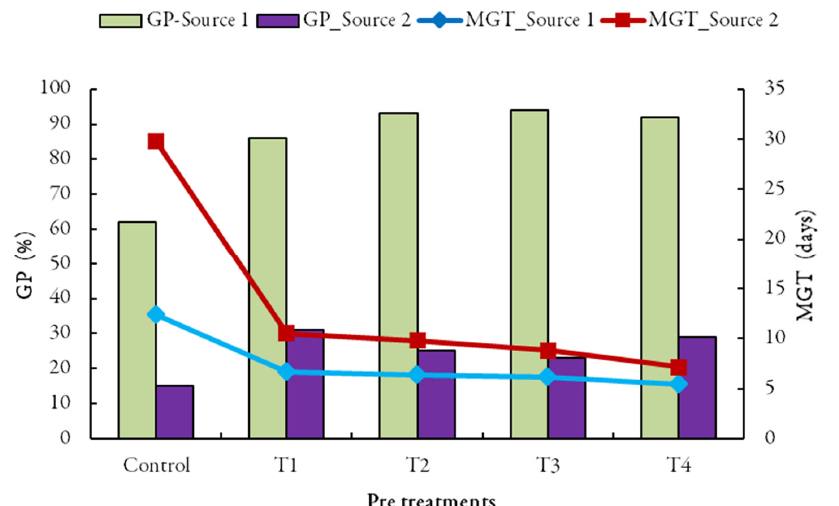
Figure 1. Germination Percent (GP) and Mean Germination Time (MGT) of Pyrus pashia seeds from Source 1 (Champawat) and Source 2 (Pithoragarh) after pre-soaking seeds in T1-100 ppm, T2-300